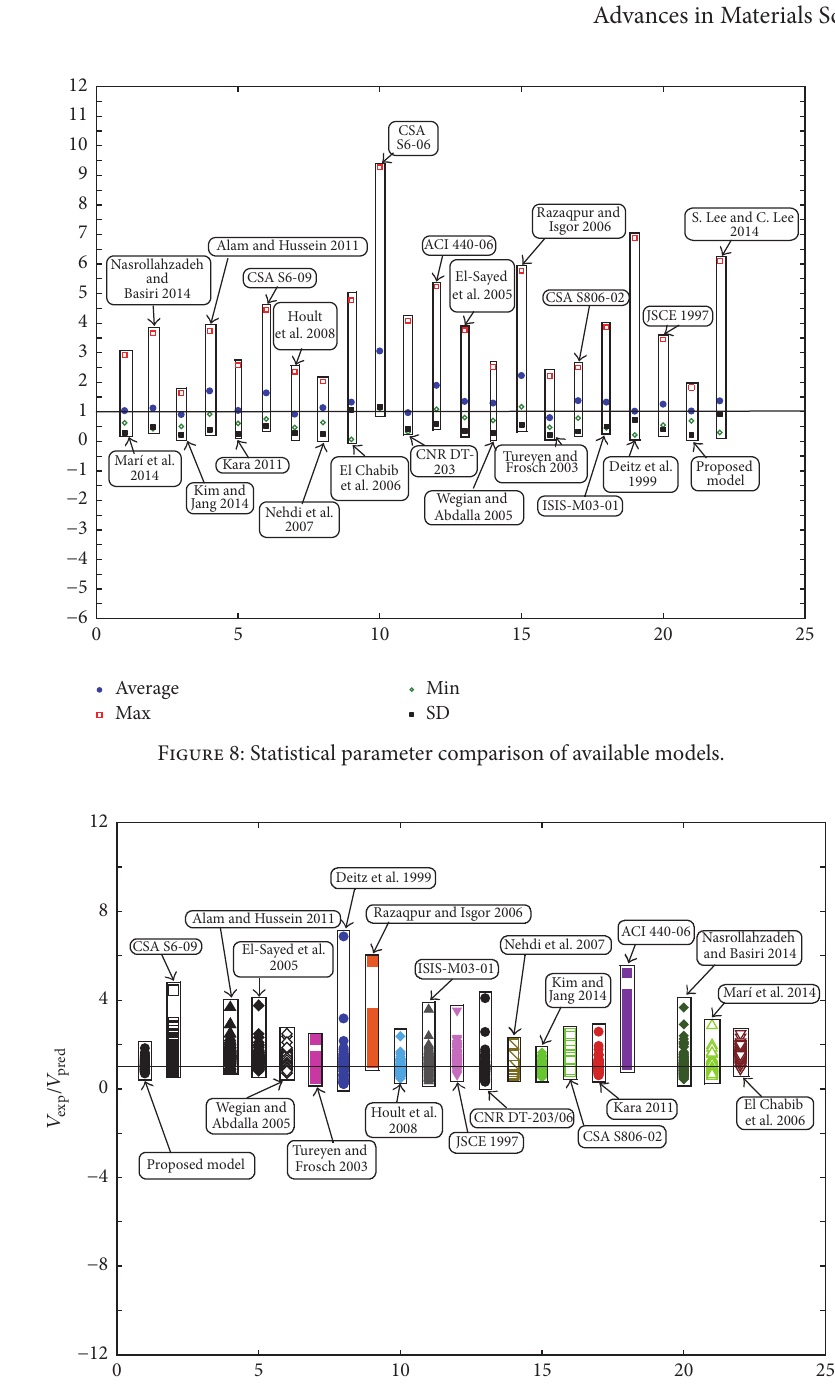
Figure 9: Experimental to predicted shear strength comparison of models and